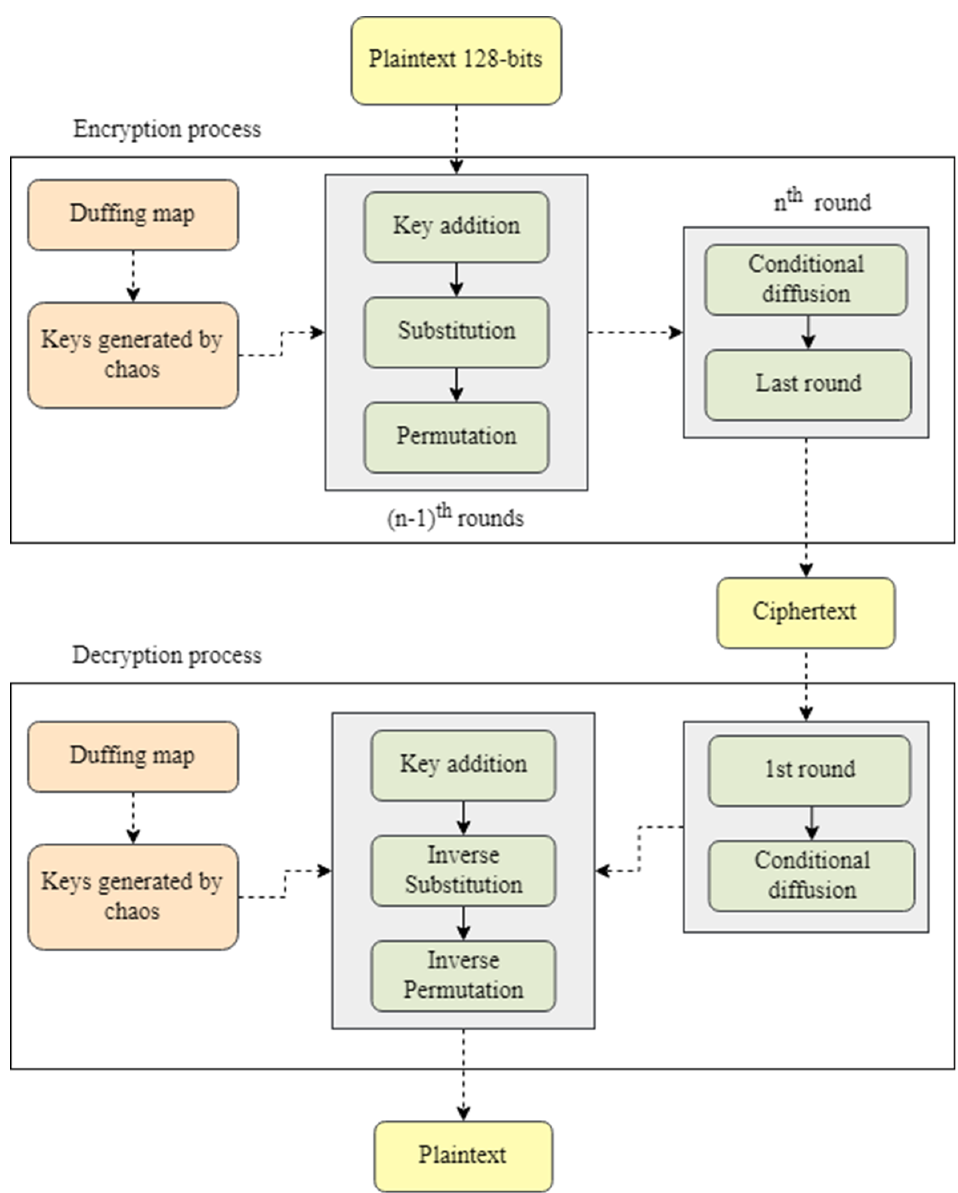
Figure 2. Flow chart illustration of modified SHARK cipher-based encryption algorithm.